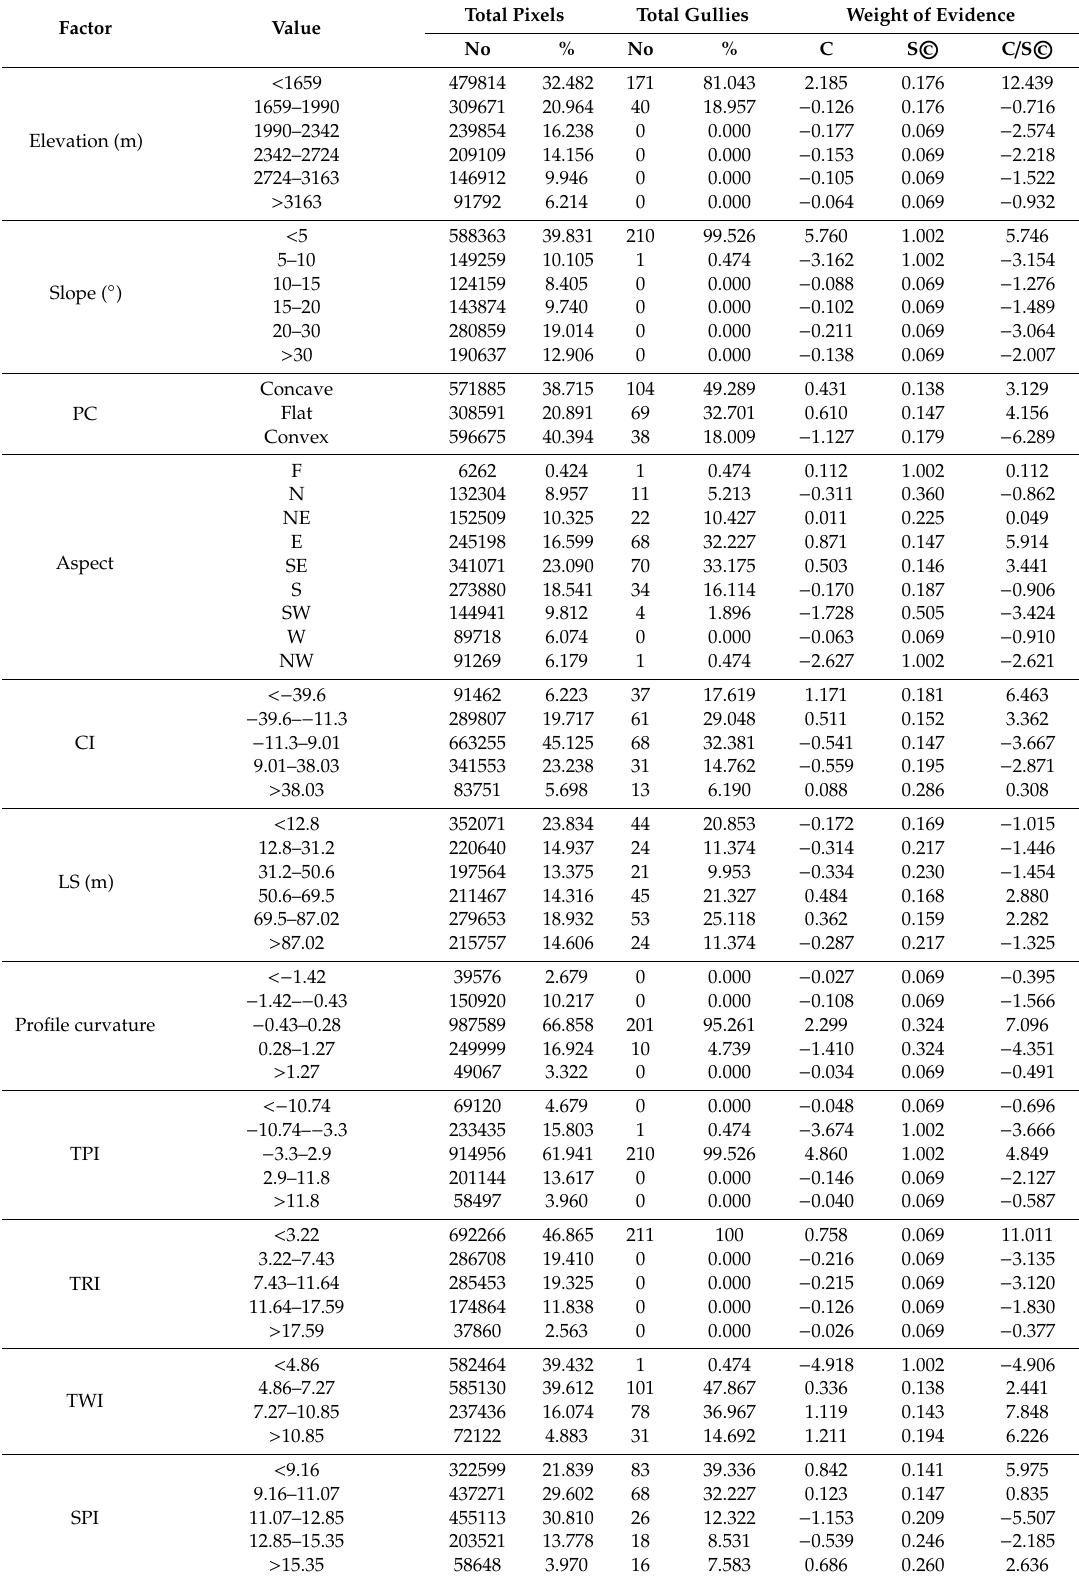
Table 3. The spatial relationship between gully erosion conditioning factors and gully